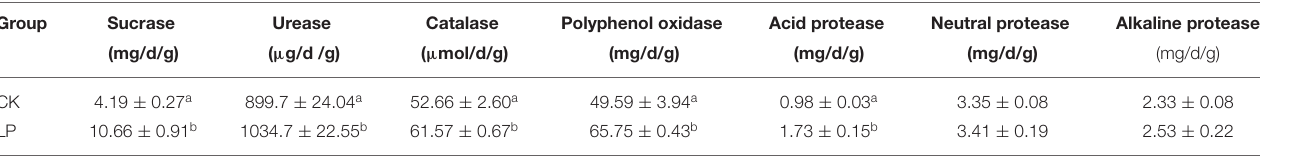
TABLE 2 | Soil enzyme activities in the LP soils and CK